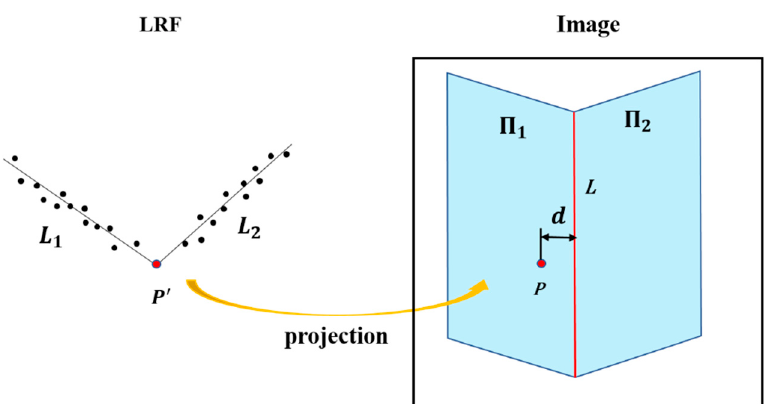
Figure 14. Schematic diagram of point-to-edge distance.